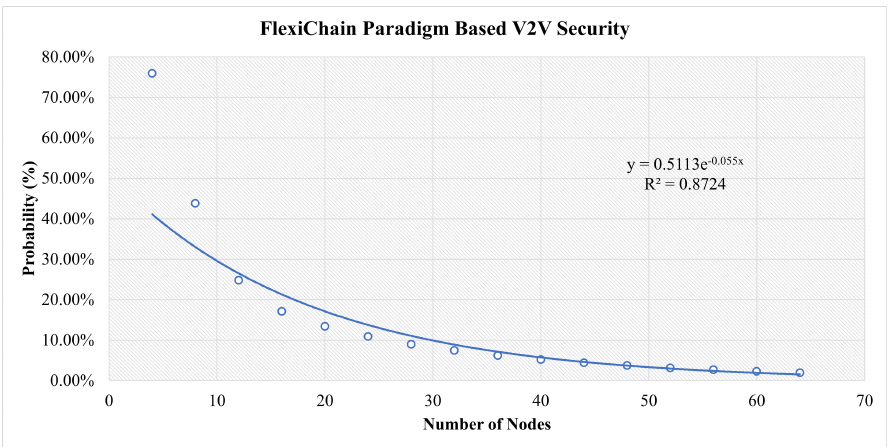
Figure 12. Results for Three Categories of Attacks in the FlexiChain-Based Scenario.